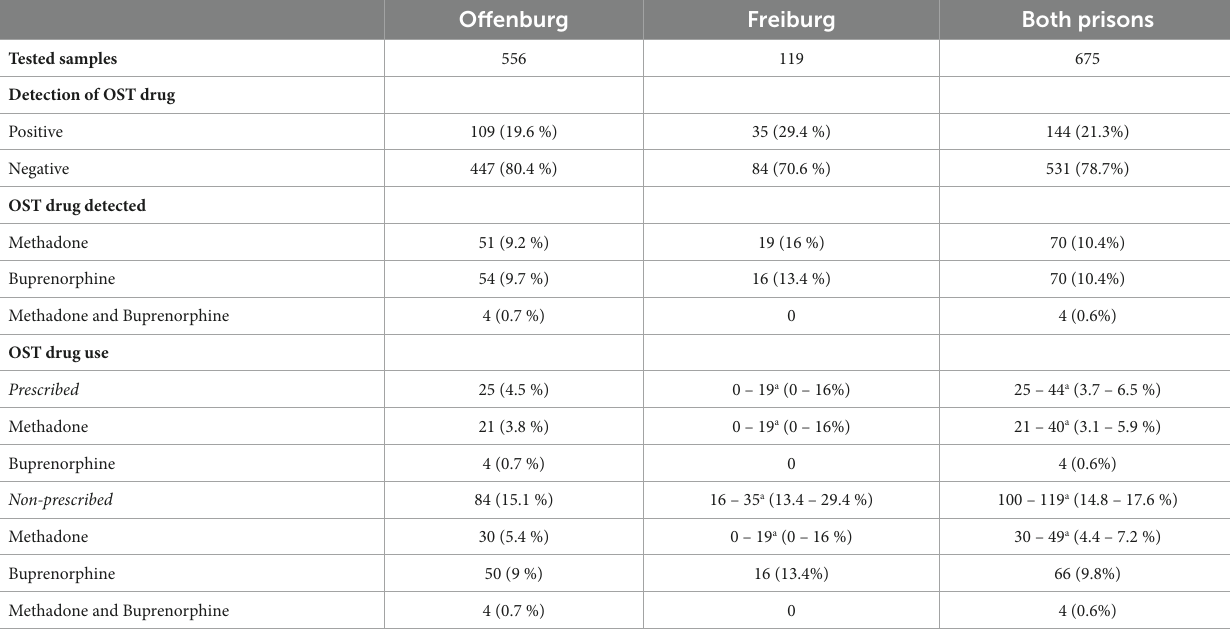
TABLE 1 Prevalence of OST drug consumption, type of OST drug detected, and type of OST drug use in the prison population